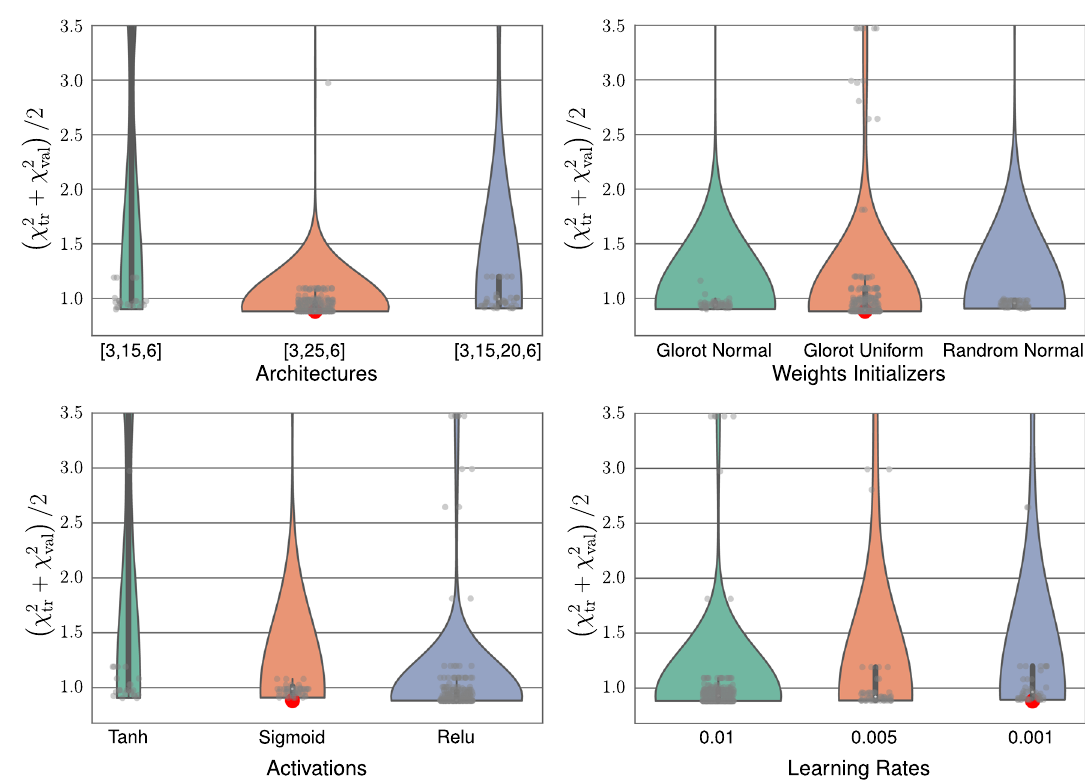
Fig. 3 Graphical representation of a hyperparameter scan for repre- sentative hyperparameters produced with 1000 trial searches using the TPEalgorithm.Thevaluesofthehyperparameterarerepresentedonthe x -axis while the hyperopt loss function is in the y -axis. In addition to